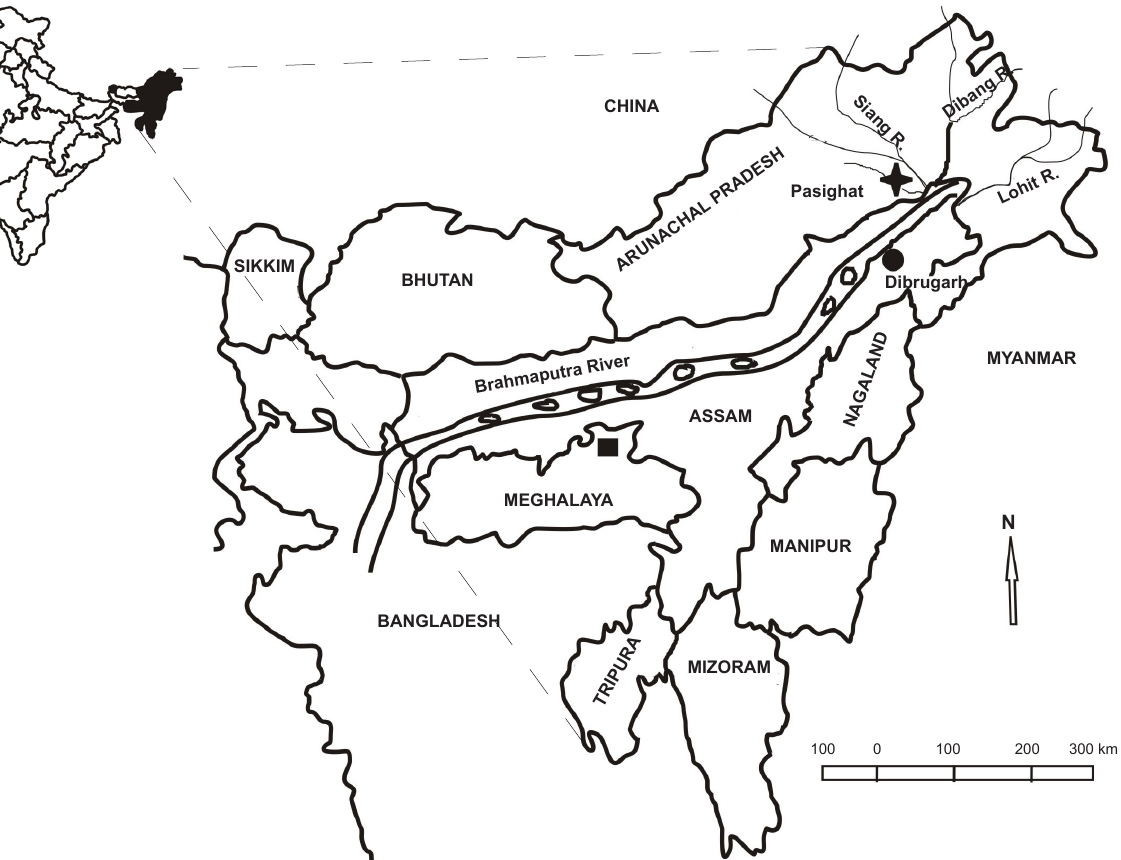
Figure 1. Map of northeastern India showing the distribution of Conta pectinata indicated by star (present collection); circle (Ng 2005) and square (Vishwanath et al.